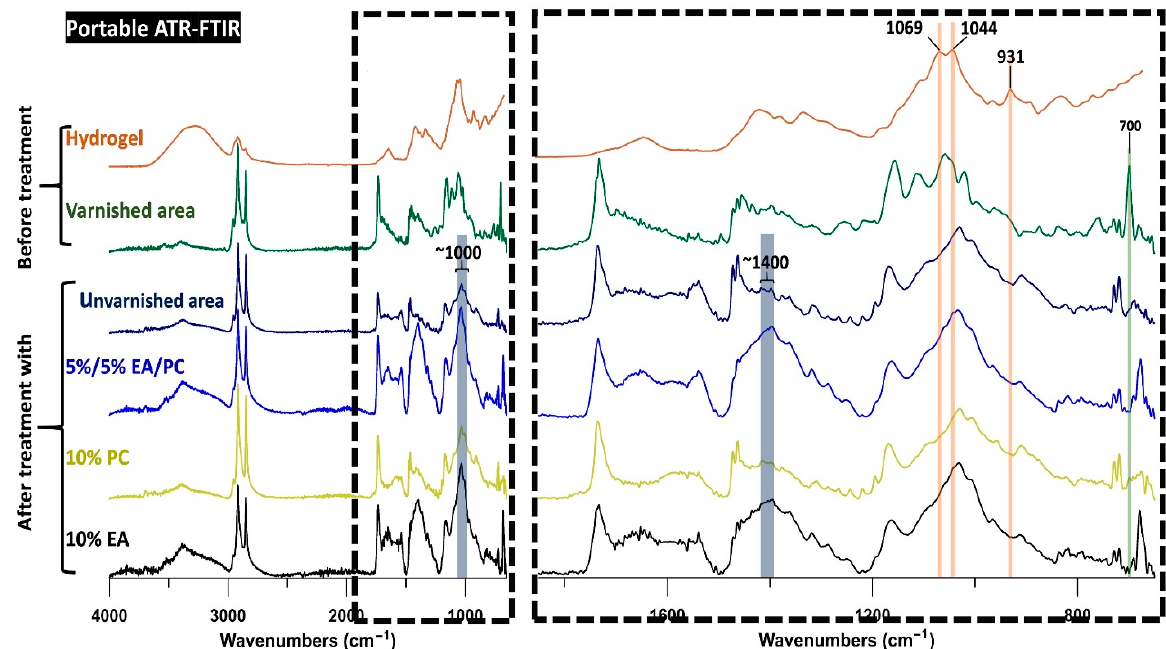
Figure 9. ATR–FTIR spectra of hydrogel, non-varnished and varnished areas, and the spots treated with three hydrogel composites (5%/5% EA/PC, 10% PC, and 10% EA) in the third-stage tests.